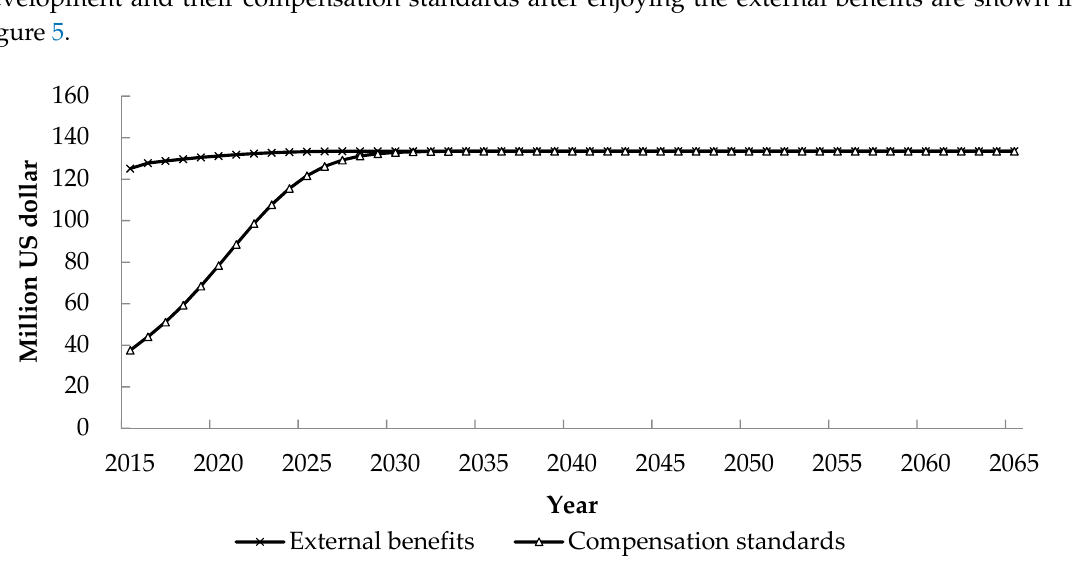
Figure 5. External benefits enjoyed and compensation standards provided by beneficiaries in E city.